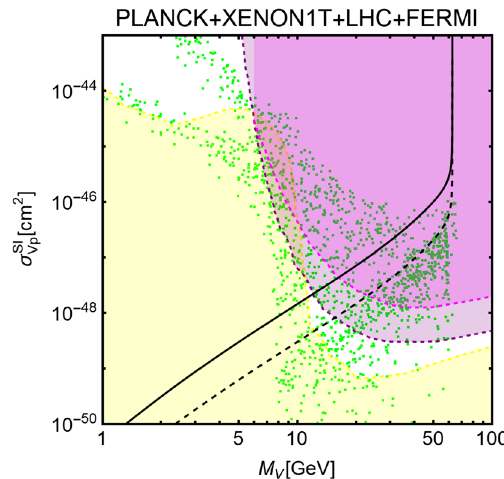
Fig. 20 ModelpointsofthedarkSU(3)model,inthe [ M V ,σ SI complying with DM constraints and featuring 2 . 5% ≤ BR ( H 1 → inv ) ≤ 11%. The solid (dashed) isocontours represent the predicted cross sections of the effective vector Higgs-portal corresponding to BR ( H 1 → inv ) = 11% ( 2 . 5% ) . The magenta/purple regions represent future sensitivities from XENONnT/DARWIN and the yellow regions the neutrino floor